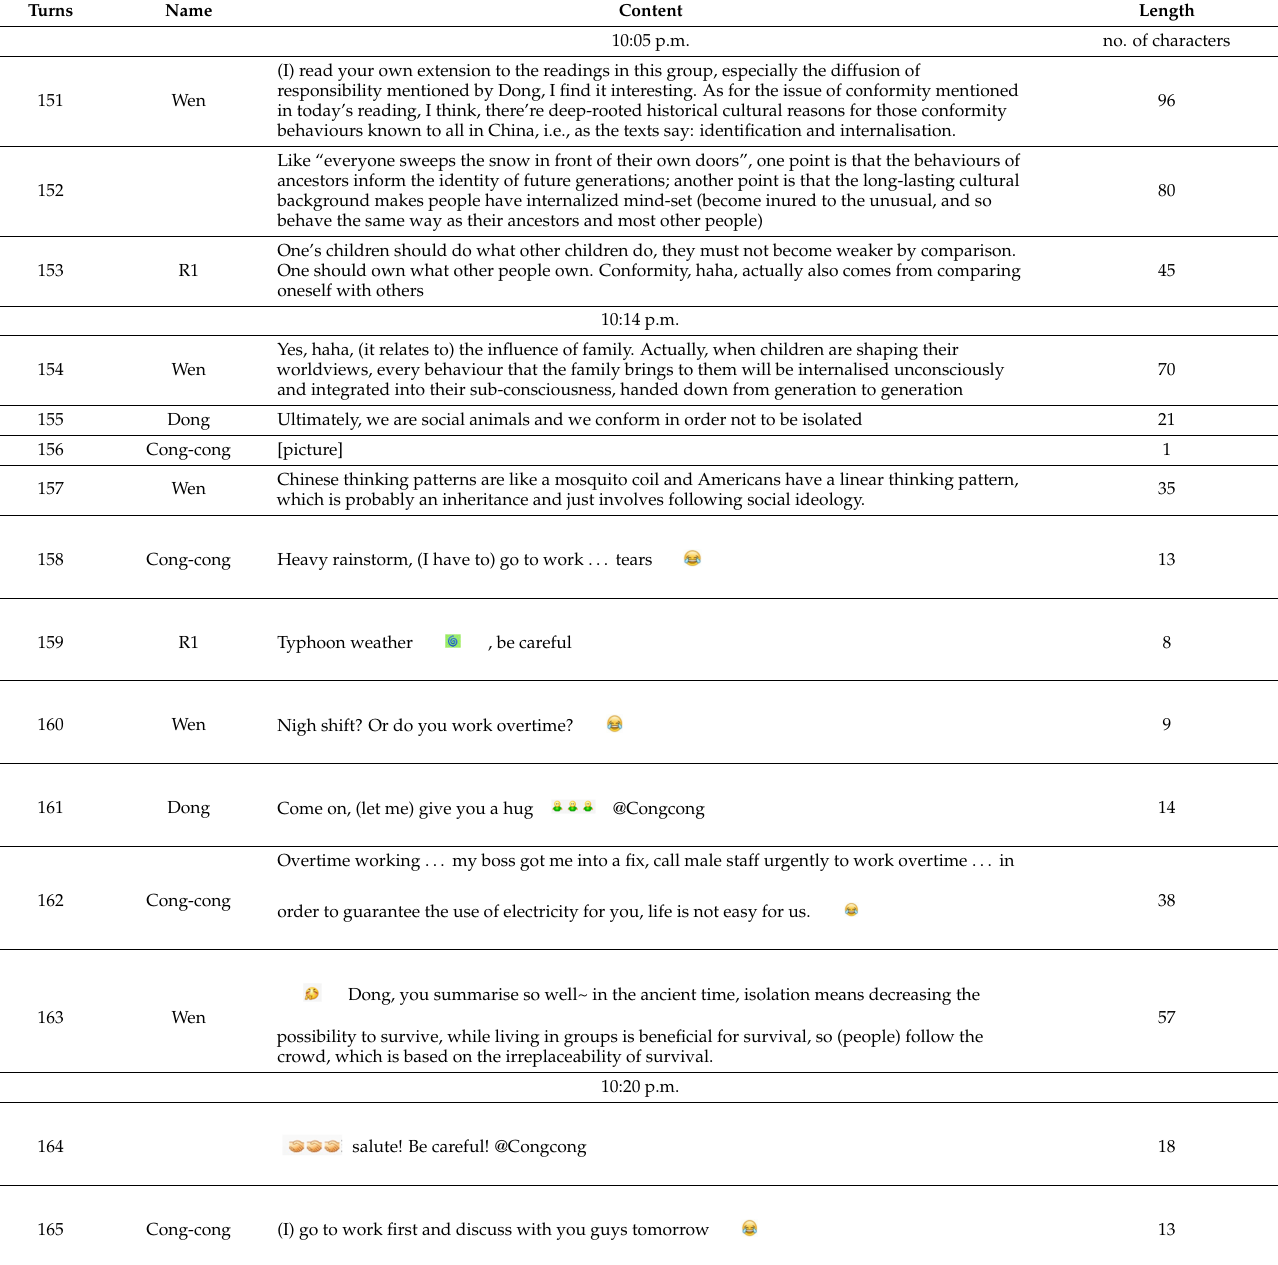
Table 6. Conversation Extract 2